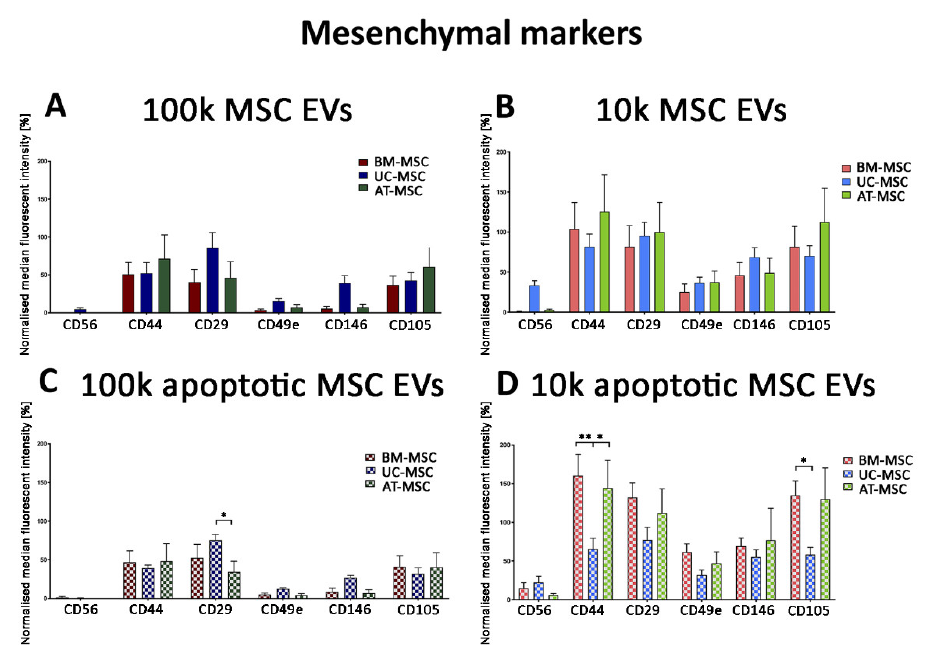
Figure 8. MACSPlex mesenchymal marker analysis of 100k and 10k MSC EVs of naive and apoptotic MSCs. ( A – D ) Histograms represent normalised fluorescence intensity of mesenchymal markers (CD56, CD44, CD29, CD49e, CD146, CD105) for 100k MSC EVs ( A , C ) and 10k MSC EVs ( B , D ) isolated from naive ( A , B ) and apoptotic ( C , D ) MSCs. BM-MSC EVs, UC-MSC EVs and AT-MSC EVs were compared. Data are expressed as median fluorescence intensity normalised to the median fluorescence intensity of tetraspanins ± SD of three different experiments. A p value < 0.05 was considered significant (* p < 0.05, ** p < 0.001).